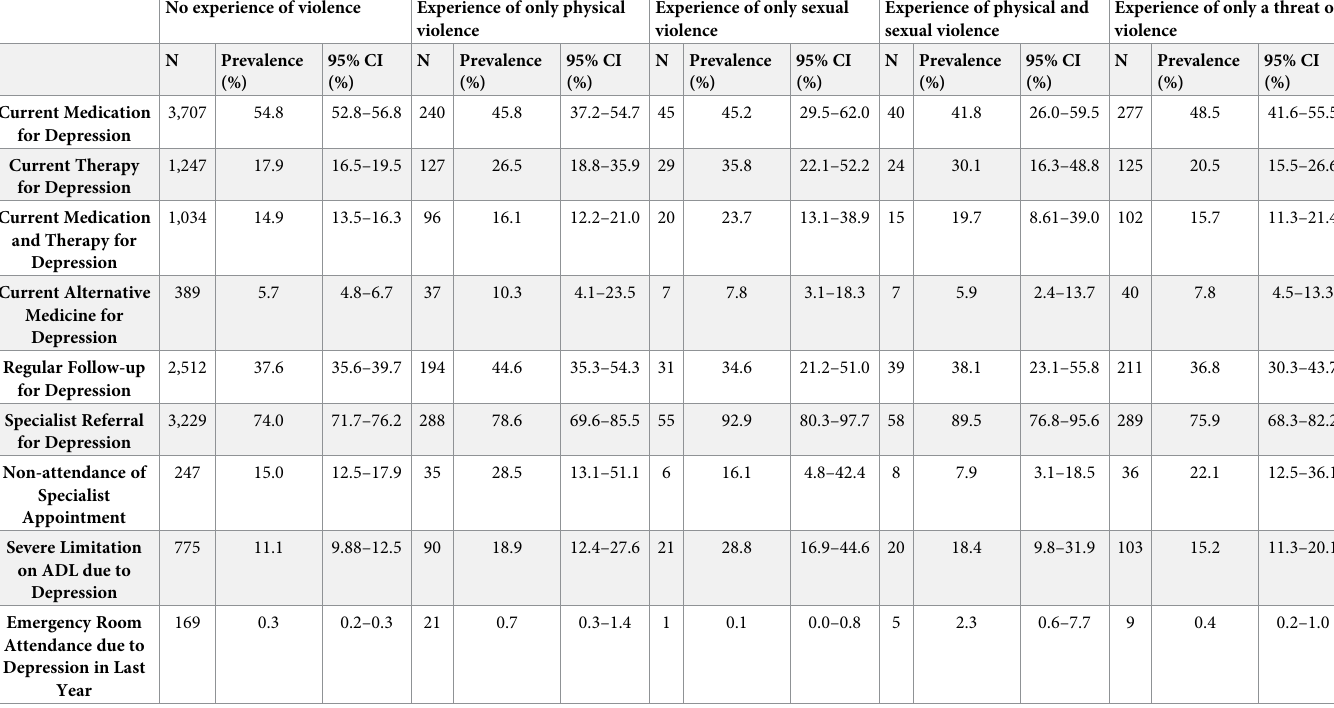
Table 3. Prevalence of depression treatments and characteristics by types of violence experienced, in those with previous clinician-diagnosed depression (n = 8,242).